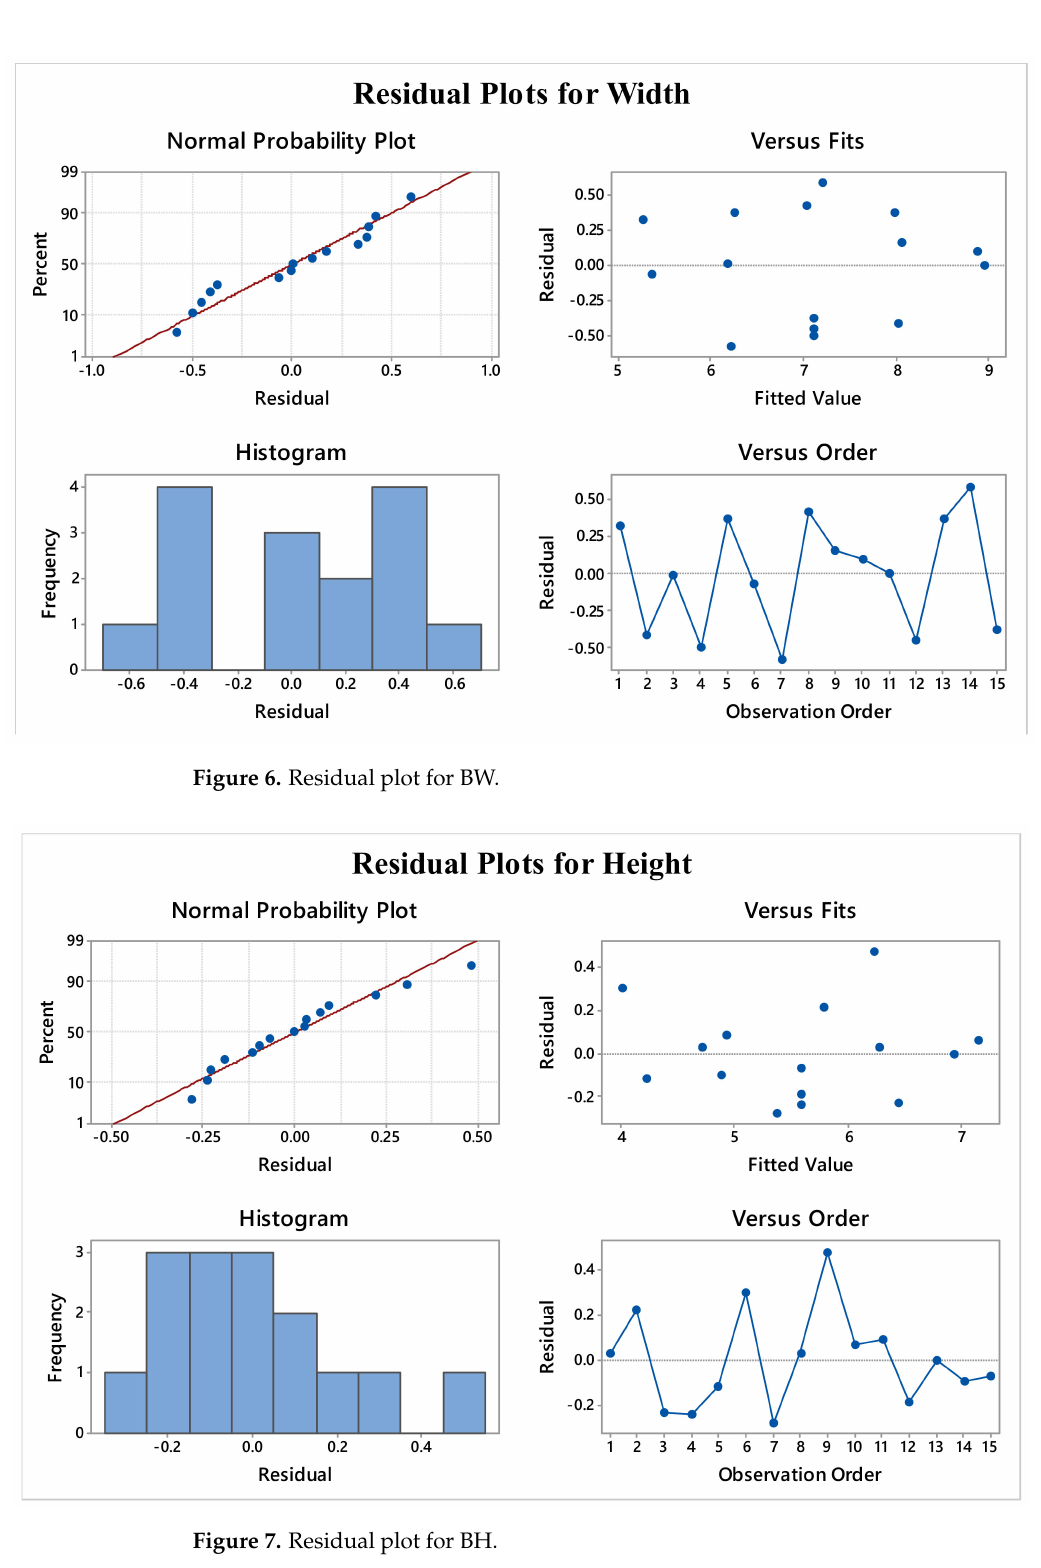
Figure 7. Residual plot for